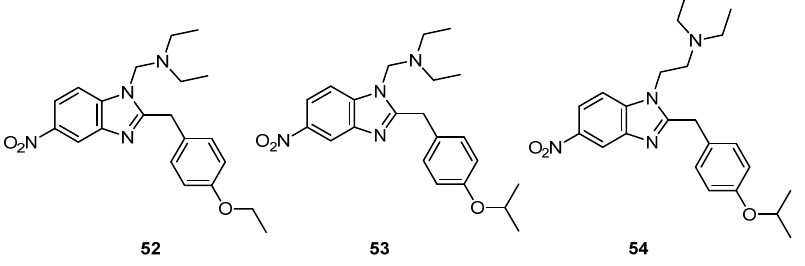
Figure 26. Etonitazene, isotonitazene, and etonitazepyne structures.